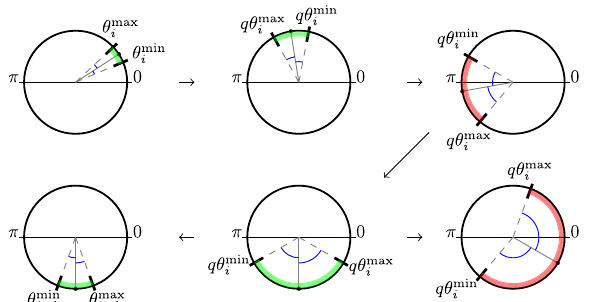
Fig. 2 FindNextK. Given an initial interval [ θ l , θ u ], k i , and K i = 4 k i + 2, FINDNEXTK determines the largest feasible k with K = 4 k + 2 ≥ 2 K i such that the scaled interval ½ K θ l ; K θ u (cid:5) lies either in the upper or mod2 π in the lower half-plane, and returns k if it exists and k i otherwise. The top left circle represents our initial knowledge about K i θ a , while other circles represent extrapolations for different values of q = K / K i . The top middle picture represents a valid q , the top right circle represents an invalid q , and so on. Note that the bottom right circle violates the condition q (cid:6) θ max i wide and cannot lie in a single half-plane. The output of FINDNEXTK in the middle bottom circle and the left bottom fi gure show the improved result in the next iteration after additional